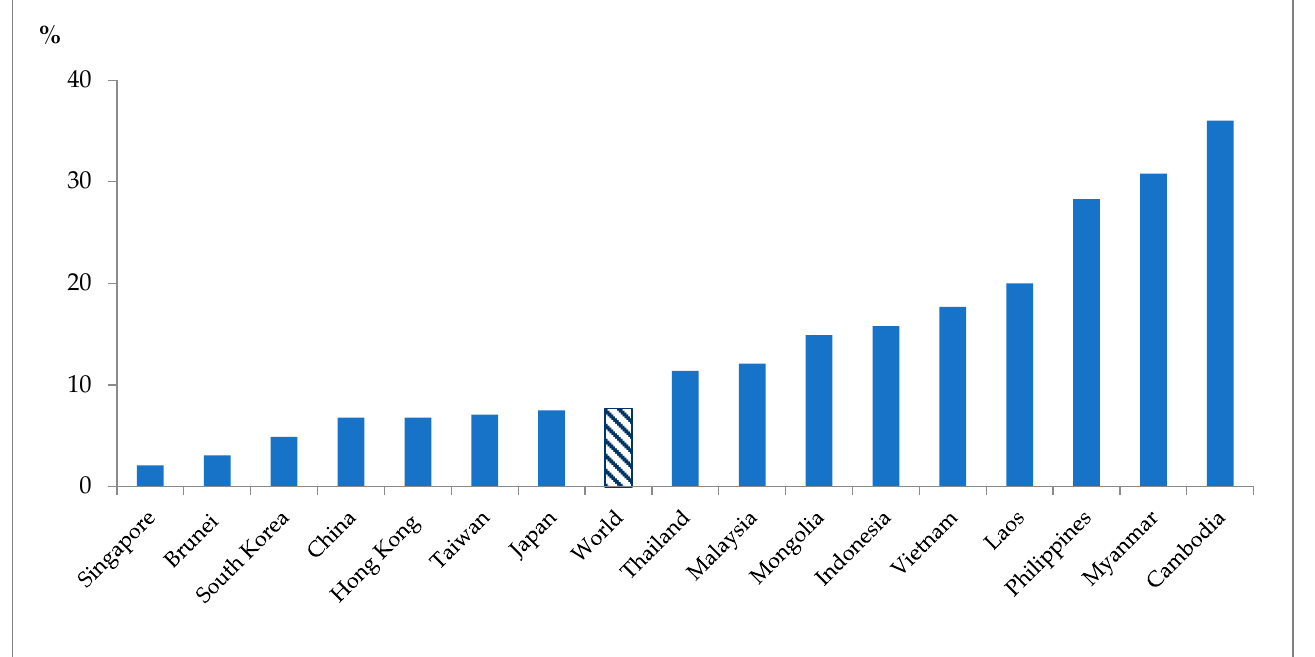
Figure 1. Share of expenditure on food in total GDP for East and Southeast Asian economies in 2017 (Percent, GDP = 100%) (Source: data retrieved and adapted from [33]).